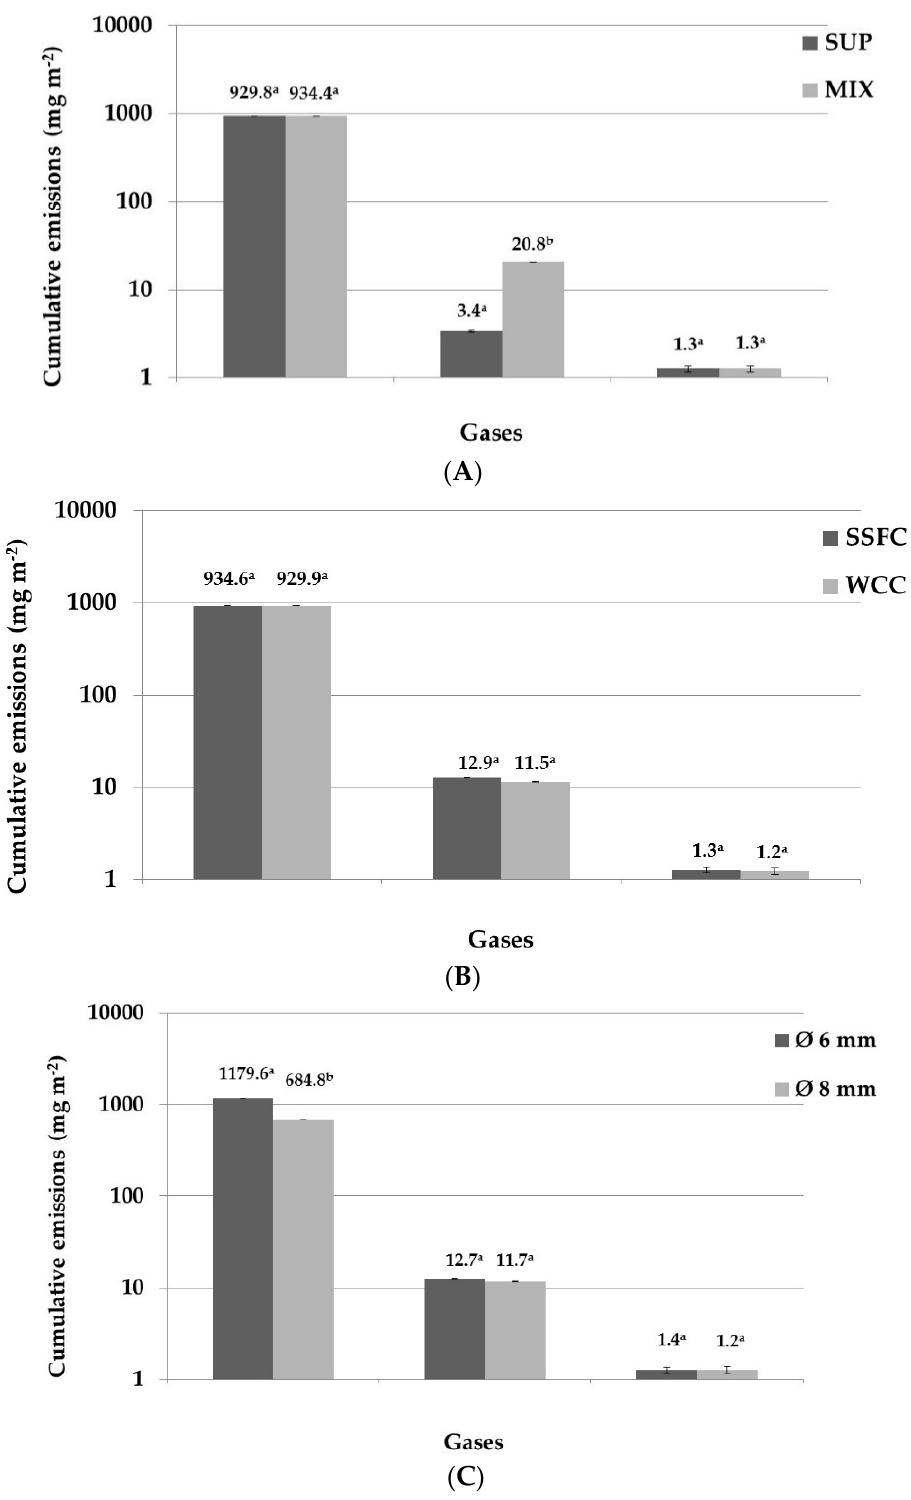
Figure 2. Effect of pellet application system [Superficial and Mixed with the soil] ( A ); compost type [Slurry Solid Fraction Compost and Wood Chips Compost] ( B ) and pellet diameter [Ø 6 mm and Ø 8 mm] ( C ) on cumulative GHG emissions recorded after soil application of the investigated pellet. Error bars represent standard error of the mean. Letters show significant difference ( p < 0.05). Table 3. Cumulative CO 2 , N 2 O and CH 4 emissions after 57 ‐ day experimental period related to SSFC (Slurry Solid Fraction Compost) pellet application. Mean value and standard error (in parentheses) of four replicates. Values with different letters are significantly different ( p < 0.05) within an individual experiment.